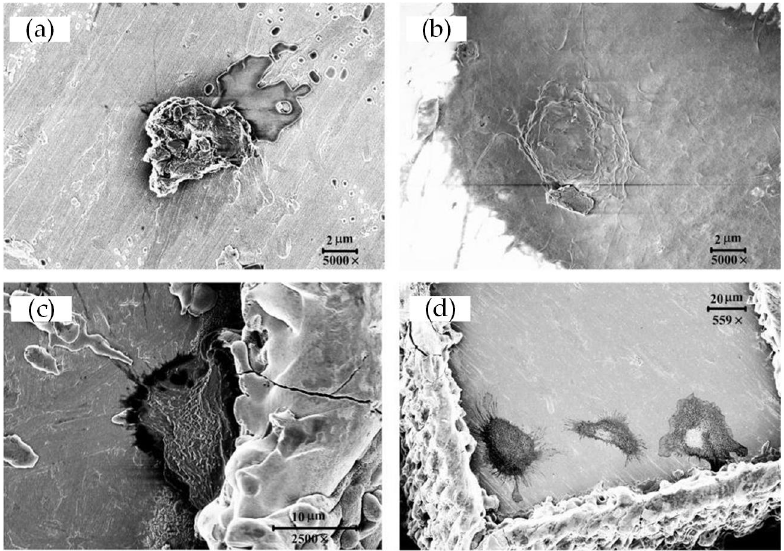
Figure 5. SEM picture of MC3T3-E1 cells morphology grown on the surface of samples (3 h): ( a ) Smooth; ( b ) Texture 1; ( c ) Texture 2; and ( d ) Texture 3.